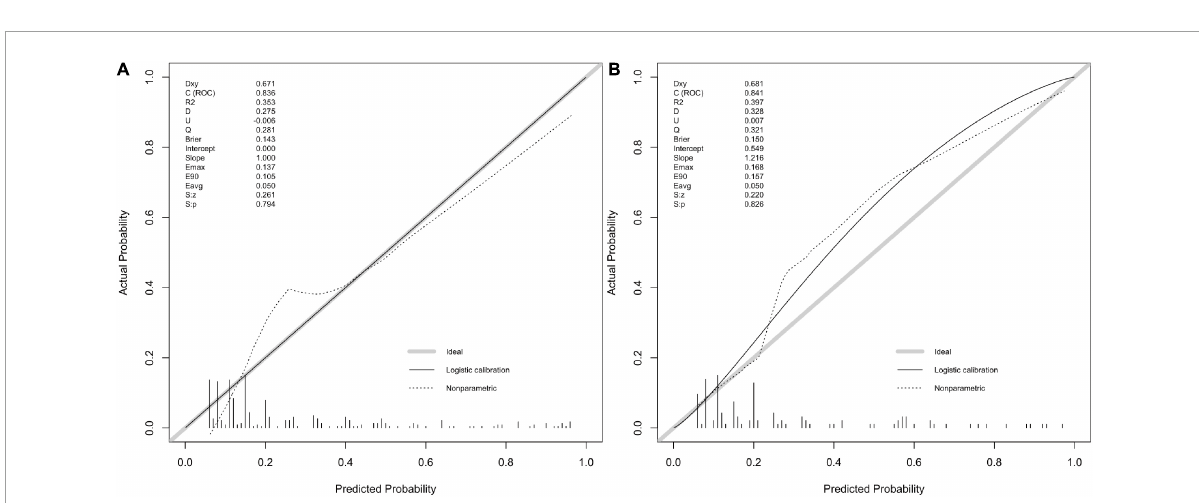
FIGURE5 (A,B) Calibration plot for the 5-factor logistic model for two external datasets which show the c(ROC) and S.p value.